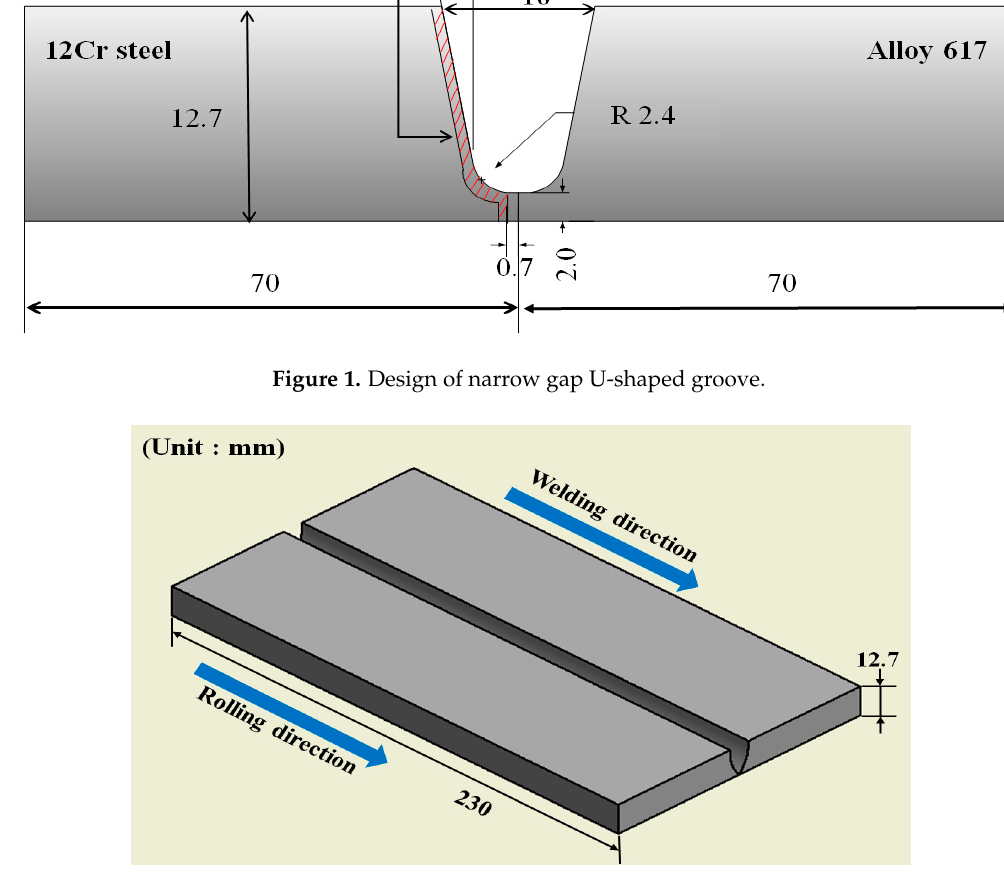
Figure 2. Welding direction. Table 3. Dissimilar material welding conditions.